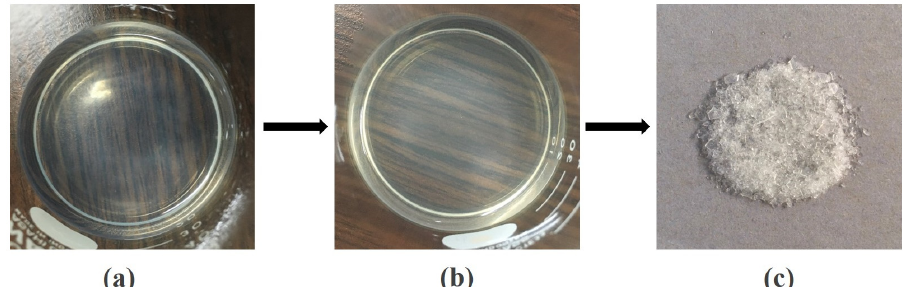
Figure 1. Transformation of ( a ) sol ( b ) hydrogel and ( c ) xerogel via the sol-gel method.